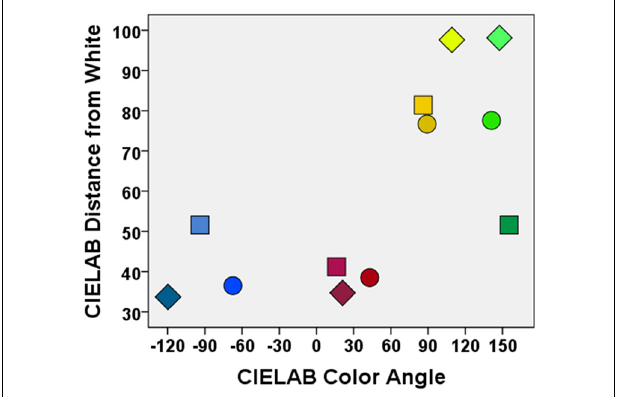
FIGURE 1 | Illustration of the colors used in the four experiments. The colors of the symbols show the colors of the stimuli in Experiment 1 (squares), Experiment 2 (disks), and Experiments 3 and 4 (diamonds). In Experiment 1, focal colors were used to control for possible effects of color typicality. In Experiment 2, colors were pairwise equated on lightness, and in Experiments 3 and 4 additionally on saturation, to account for possible confounding effects of these color attributes. Note that colors will not be correctly displayed in print or on an uncalibrated video